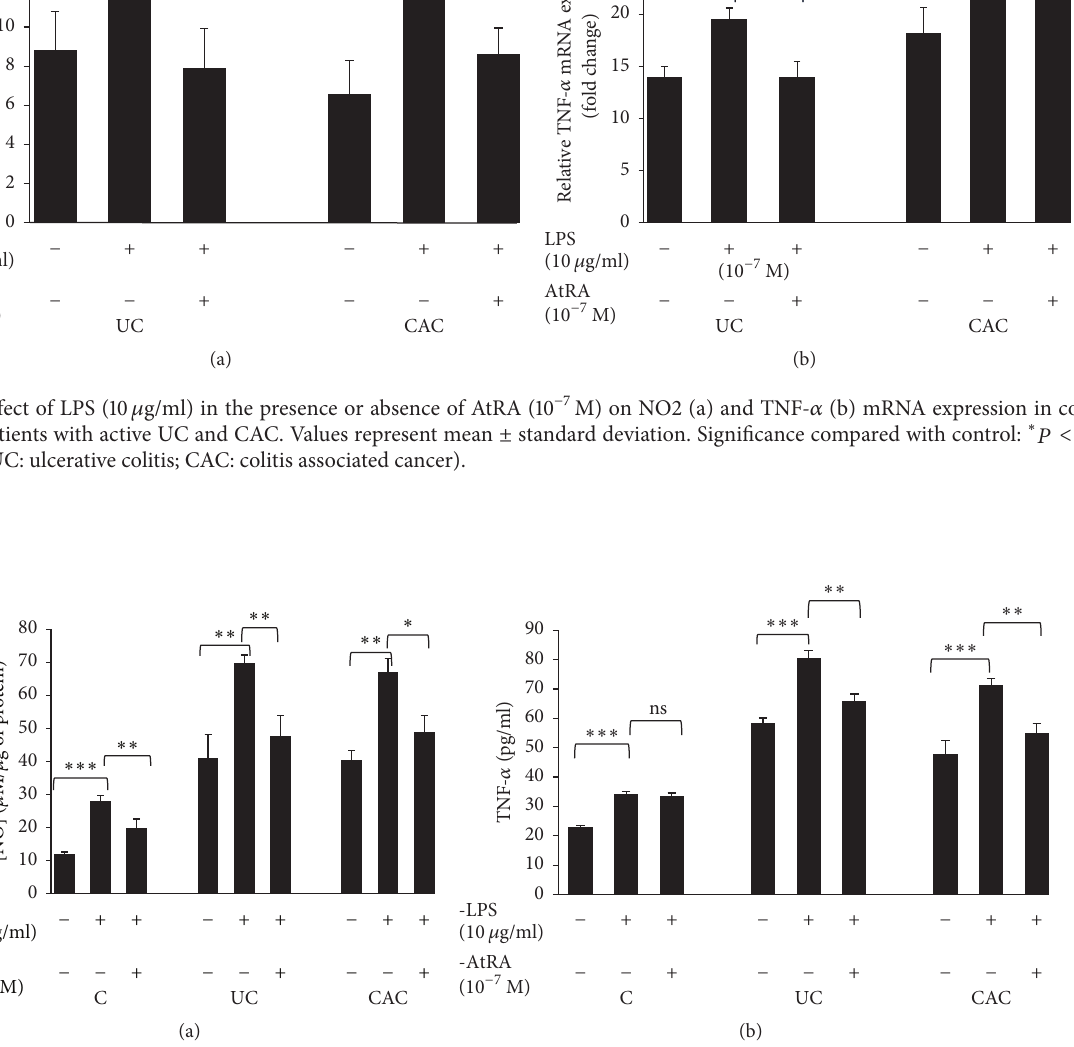
Figure 12: Effect of LPS (10 𝜇 g/ml) in the presence or absence of AtRA (10 −7 M) on NO (a) and TNF- 𝛼 (b) production by colonic mucosa of patients with active UC and CAC. Values represent mean ± standard deviation. Significance compared with control: ∗ 𝑃 < 0.05 , ∗∗ 𝑃 < 0.01 , and ∗∗∗ 𝑃 < 0.001 . ns, no significant difference, 𝑃 > 0.05 (UC: ulcerative colitis; CAC: colitis associated cancer; C: control, normal